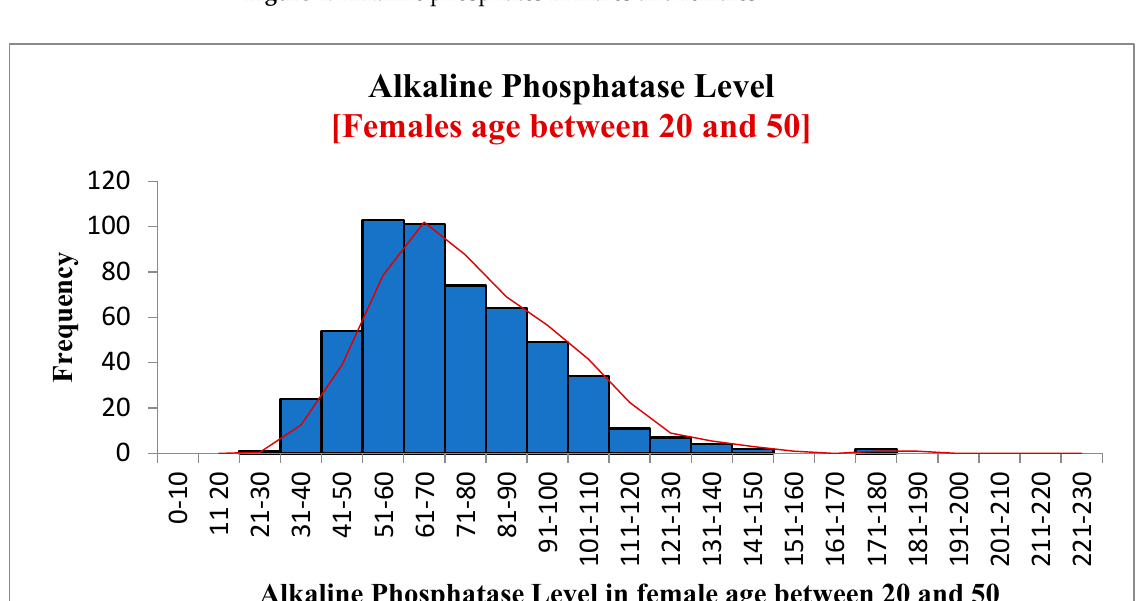
Figure 5. Alkaline phosphates in females aged 20–50.